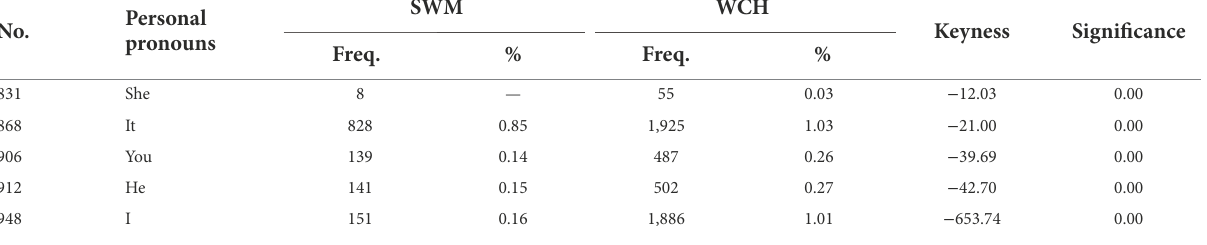
TABLE 5 Key personal pronouns in CWM (in comparison with WCH).